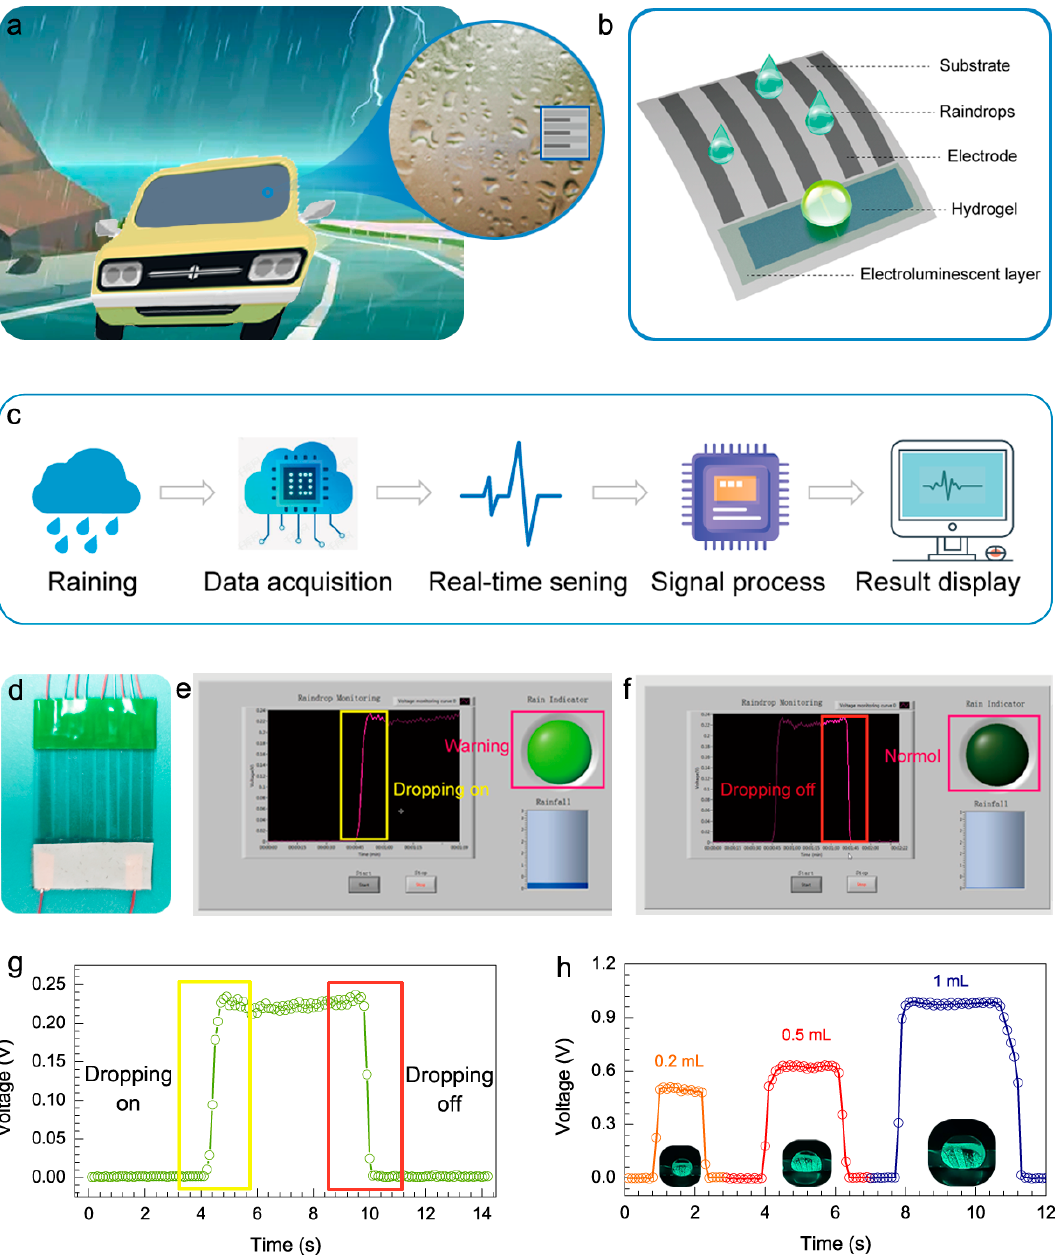
Figure 5. Demonstration of the developed self-powered raindrop visual sensing system. ( a ) Application scenario diagram for weather-monitoring sensors. ( b ) Schematic diagram of the structure of the sensor. ( c ) Real-time demonstration process in an actual application of the raindrop characteristic statistical system. ( d ) Physical view of the sensor. ( e , f ) Screenshot showing the self-powered raindrop characteristic statistical system monitoring changes in output voltage data. ( g ) Corresponding voltage data for falling raindrops. ( h ) Output voltage corresponding to various rainfall levels.